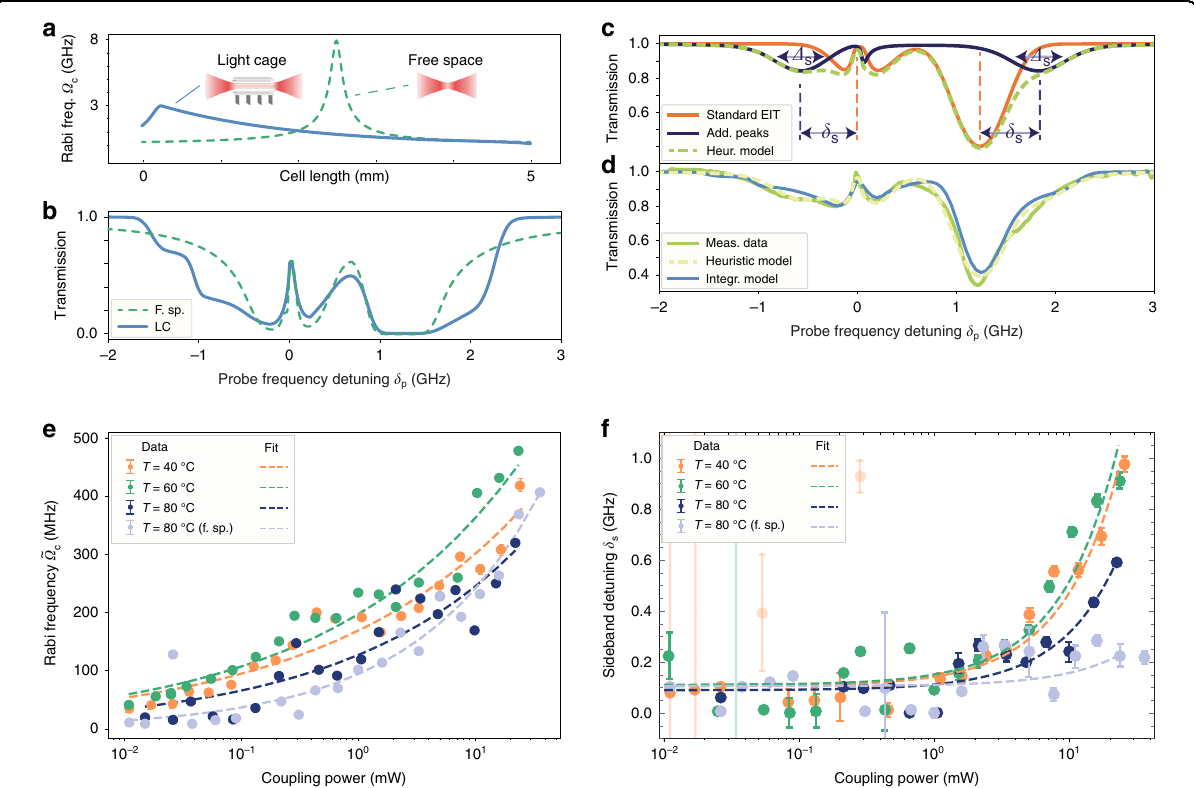
Fig. 3 Comparison of EIT in the LC and free space. a Coupling- fi eld amplitude along the propagation axis, expressed as Rabi frequency Ω c ( z ), for the free-space (dashed line) and LC (solid line) situation. b Calculated transmission spectra for free space (dashed) and the LC (solid). c Heuristic fi tting curve (dashed, example: P c = 22.1 mW, T = 80 °C) decomposed into an analytic EIT curve (orange) and sidebands (blue) with relative detuning δ S and width Δ S . d Comparison of heuristic fi tting, numerical effective curve and measured data. e Effective Rabi frequencies ~ Ω c in the LC and free space (f. sp.) derived from the data as a function of coupling-laser power P c for different oven temperatures (error bars smaller than ticks). The dashed lines are fi ts ∝ ( P ¼ ð 0 : 26 ± 0 : 05 Þ in the LC and m = (0.41 ± 0.04) in free space (errors are the standard deviation of the fi t), m with an average exponent m LC c ) fs respectively. f Obtained detunings δ s of the absorbing sidebands in the LC and free space (f.sp.) as a function of coupling laser power for different oven